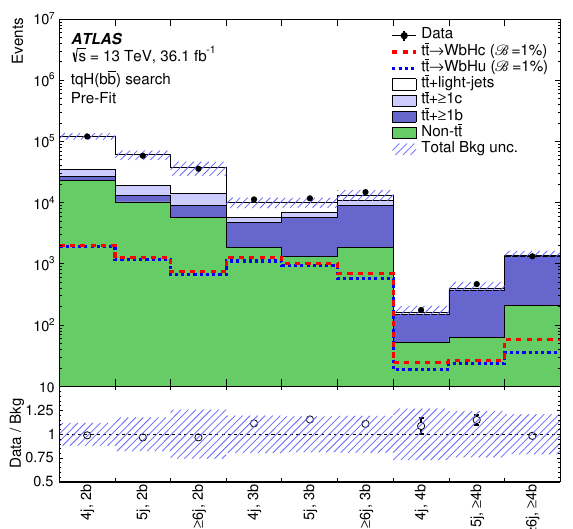
Figure 1 . tqH ( b (cid:22) b ) search: comparison between the data and predicted background for the event yields in each of the analysis regions considered before the (cid:12)t to data (\Pre-Fit"). All events satisfy the preselection requirements, whereas those with exactly two b -tagged jets are in addition required to have a value of the likelihood discriminant above 0.6 (see section 6.2). Backgrounds are normalised to their nominal cross sections. The small contributions from W=Z +jets, single-top- quark, diboson and multijet backgrounds are combined into a single background source referred to as \Non- t (cid:22) t ". The expected t (cid:22) t ! WbHc and t (cid:22) t ! WbHu signals (dashed histograms) are shown separately normalised to B ( t ! Hq ) = 1%. The bottom panel displays the ratio of data to the SM background (\Bkg") prediction. The hashed area represents the total uncertainty of the background, excluding the normalisation uncertainty of the t (cid:22) t + (cid:21) 1 b background, which is determined via a likelihood (cid:12)t to